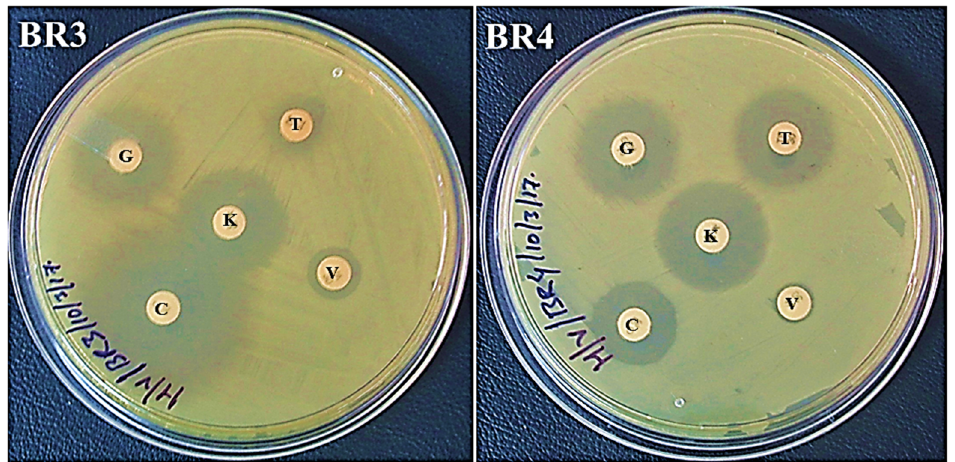
Figure 2. Growth of isolates BR3 and BR4 on nutrient agar plates. ( A ) Nutrient agar plate without ampicillin. ( B ) Nutrient agar plate with ampicillin.